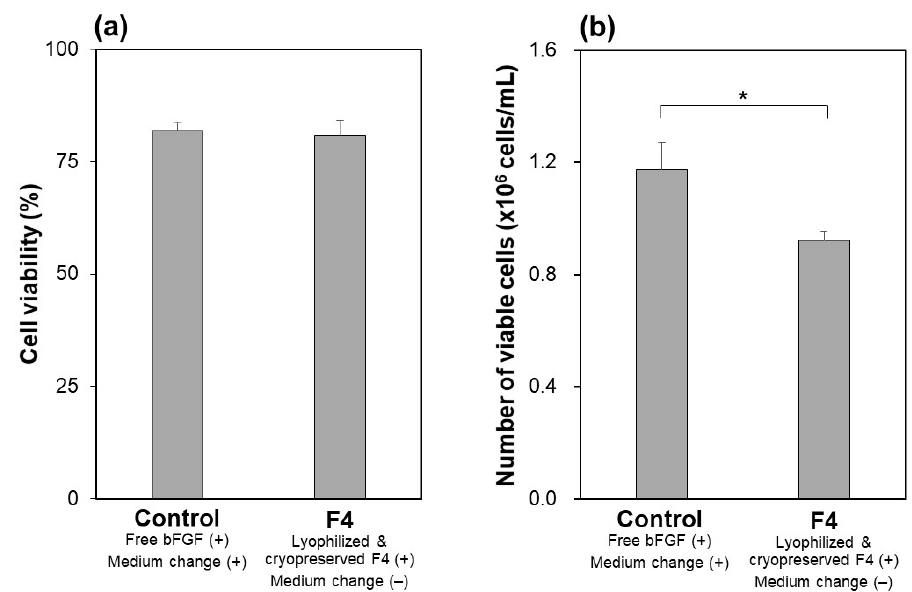
Figure 10. ( a ) Viability of iPSCs and ( b ) relative number of viable iPSCs on Day 3 in medium-change-free continuous culture with the lyophilized and cryopreserved (3 months) F4 membrane (F4 group) or in standard culture using bFGF-containing medium with daily medium refreshment (control group) (average + SD; n = 3; * p < 0.05).